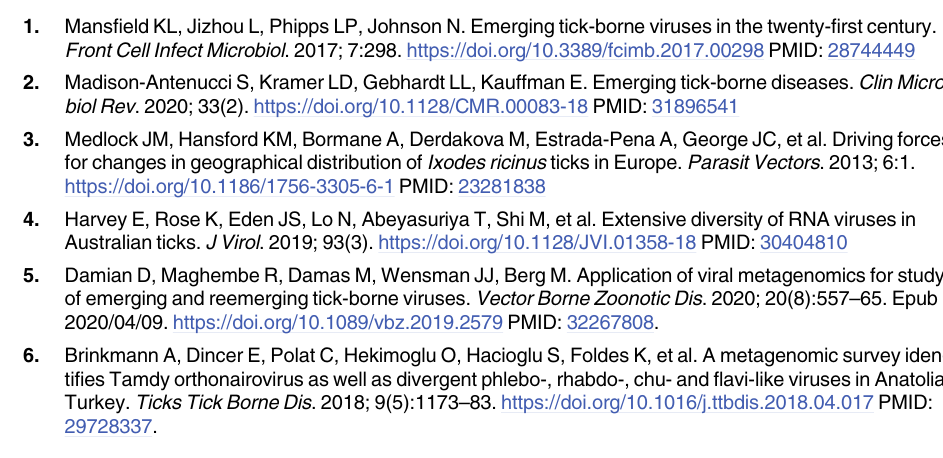
S18 Table. Nucleotide sequence similarity of RdRp genome (upper right) and amino acid sequence similarity of RdRp (lower left) of JPLV1. S19 Table. Nucleotide sequence similarity of the complete CDS (upper right) and amino acid sequence similarity of RdRp (lower left) of FLTV. S20 Table. Nucleotide sequence identities of complete cds (upper right) and amino acid sequence identities of RdRp (lower left) of ISAV1 and XTAV1. S21 Table. Nucleotide sequence identities of complete cds (upper right) and amino acid sequence identities of RdRp (lower left) of JLLV2. S22 Table. Nucleotide sequence identities of complete genome (upper right) of